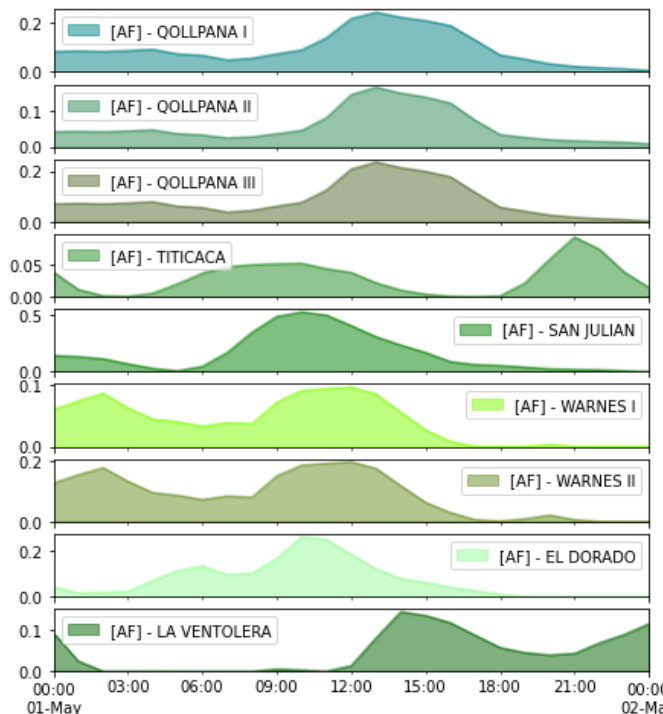
Figure 17. Wind Resource Availability Factor (1 May 2025).